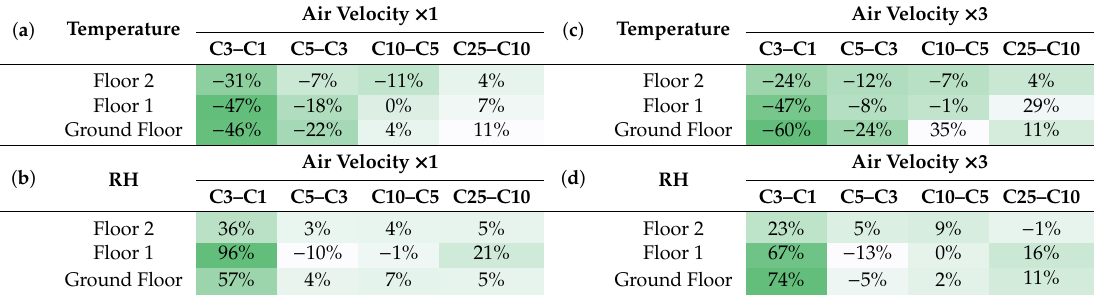
Table 5. Temperature and Relative Humidity with variation of the thickness of the air chamber. Darker colour indicates the higher values.